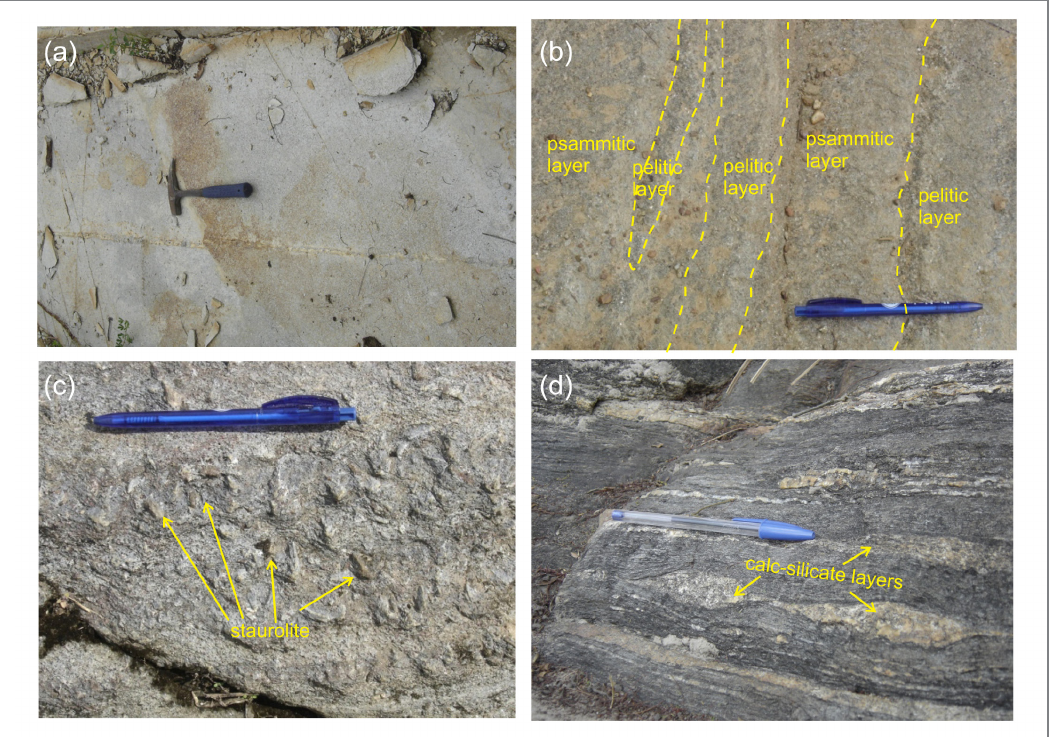
Figure 2 - Lithotypes in the study area. (a) Muscovite quartzite with horizontal foliation. (b) Metarhythmite showing alternating pelitic-rich and psammitic-rich bands. (c) Muscovite biotite schist with porphyroblasts of staurolite. (d) Boudinage layers of calc-silicate rock in pelitic